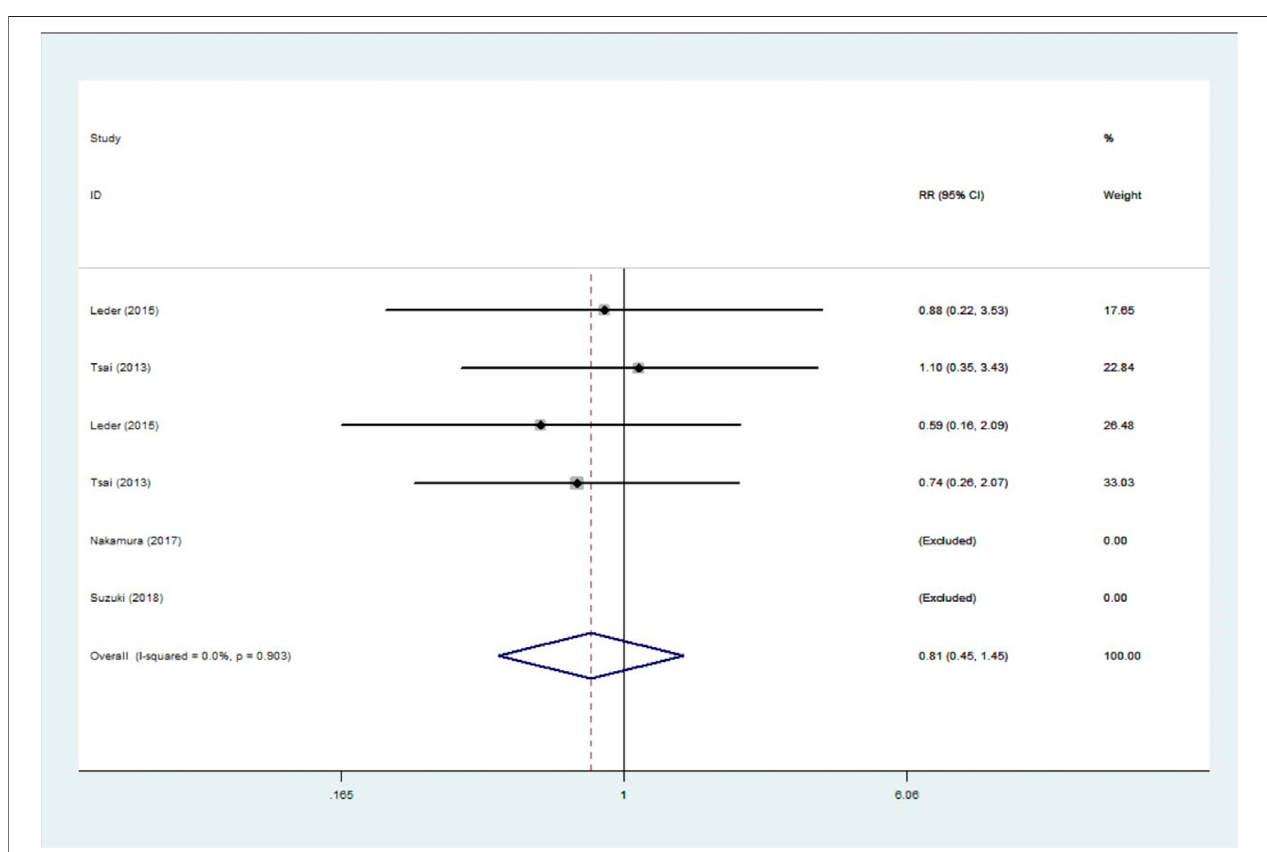
FIGURE 4 | Forest plot for incidence of adverse event with combination treatment versus